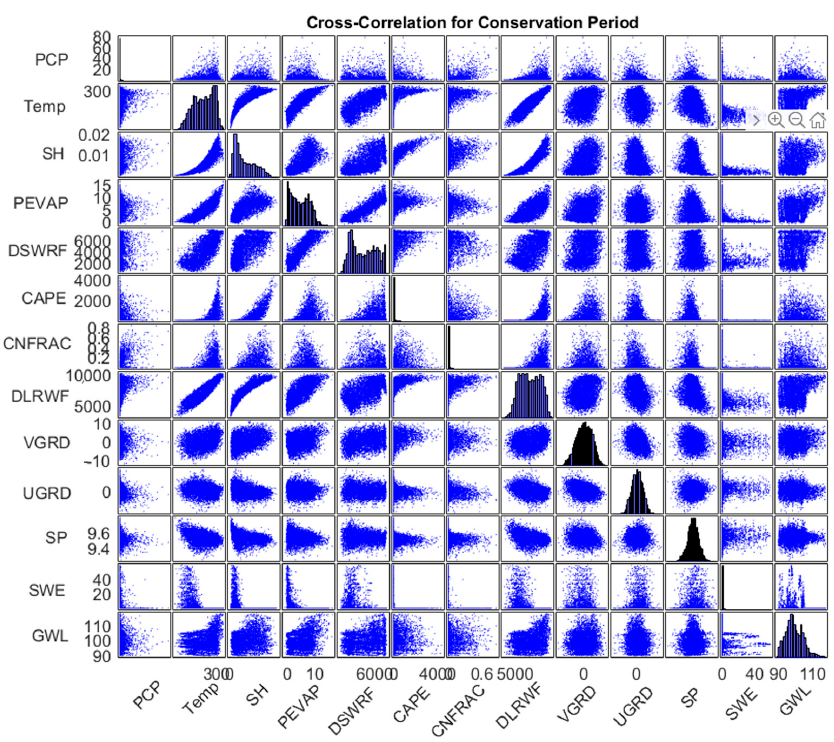
Figure A2. Cross ‐ correlation pair plot for all 13 predictive variables over the conservation period (2005–2020).